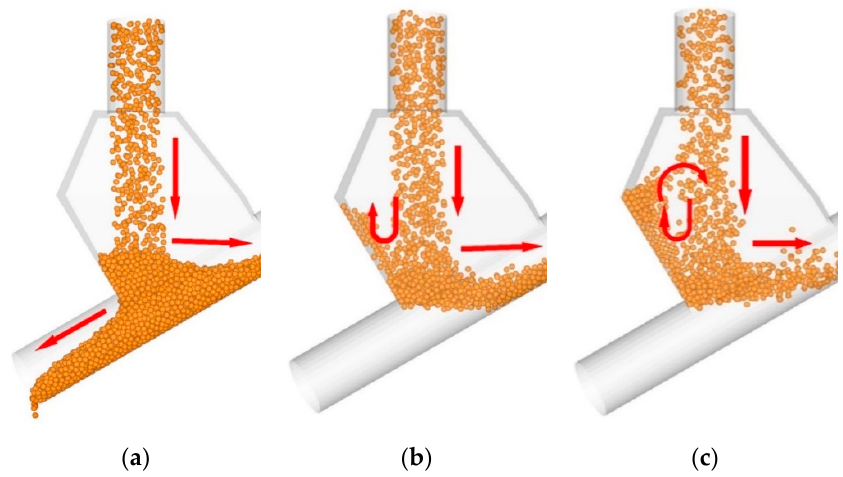
Figure 9. Progressive motions of particles in the mixing cavity under different cases. ( a ) Case 1; ( b ) Case 2 and ( c ) Case 3. ( b ) Case 2 and ( c ) Case